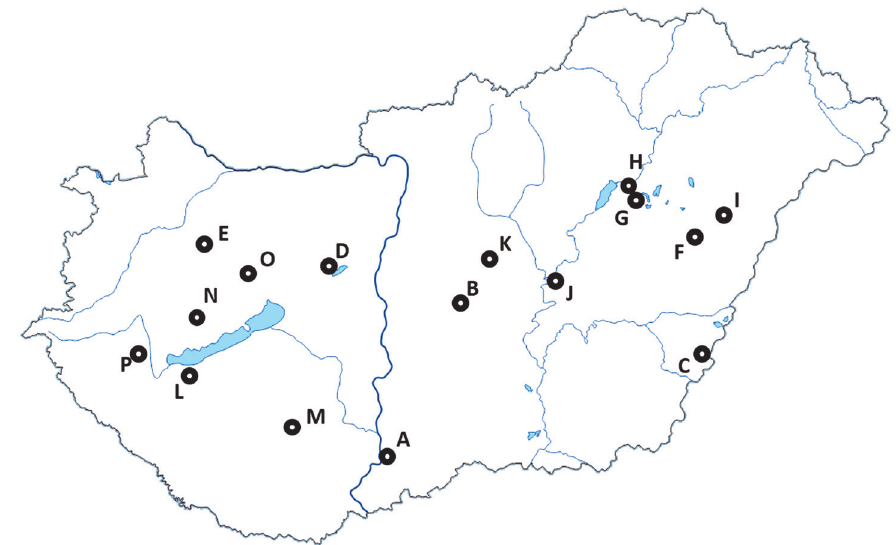
Figure 1. Sampling locations of the 16 Limousin